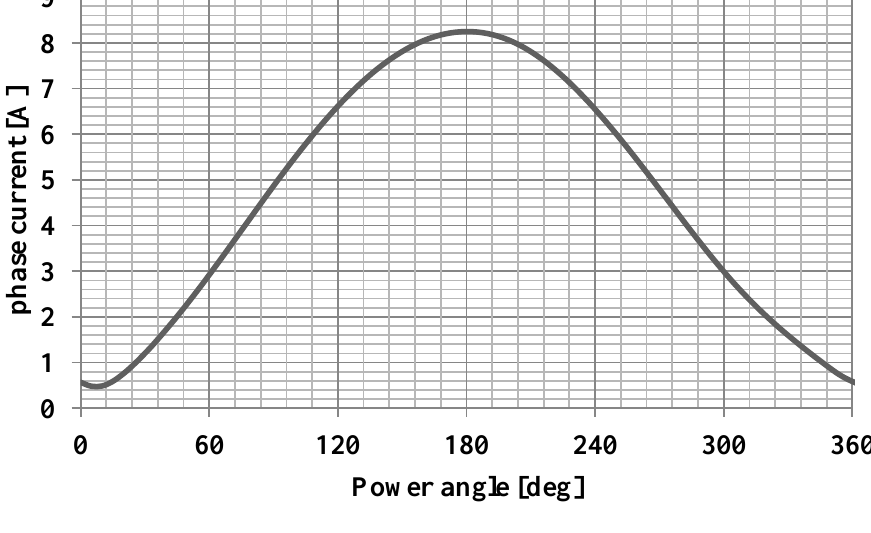
Figure 7. The characteristics of phase current as a function of the power